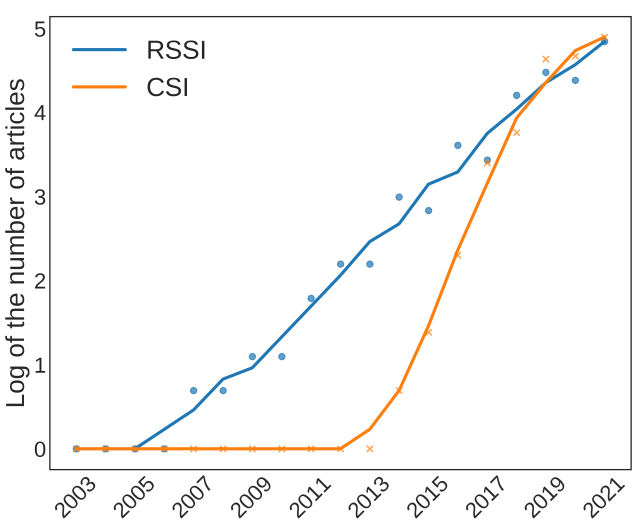
Figure 10. Count of the number of occurrences of CSI and RSS in the logarithmic